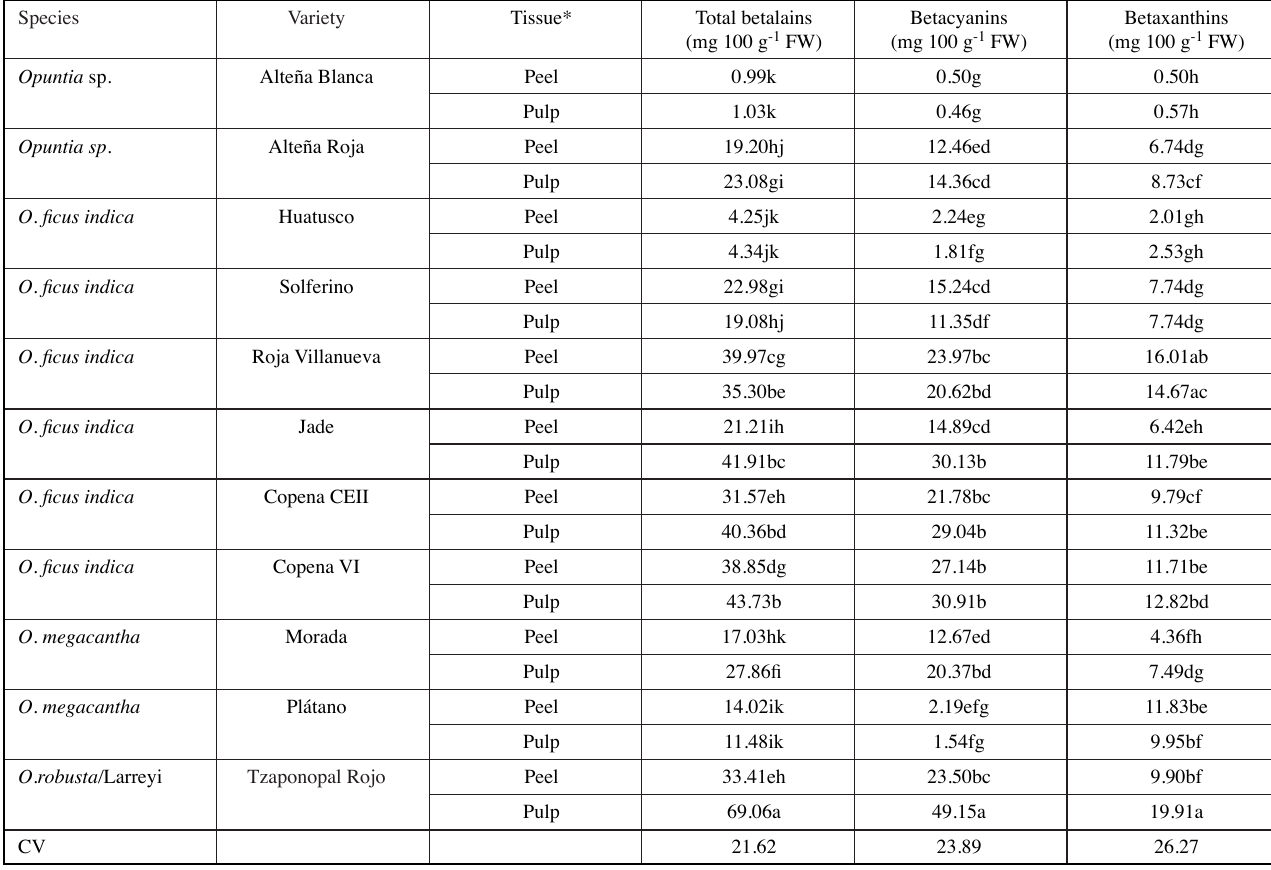
Tab. 2: Content of total betalains, betacyanins, and betaxanthins in the fruit of 11 varieties and species of prickly pear ( Opuntia sp.) harvested at the Universidad Autónoma Chapingo Experimental Station, Chapingo, Mexico. Species